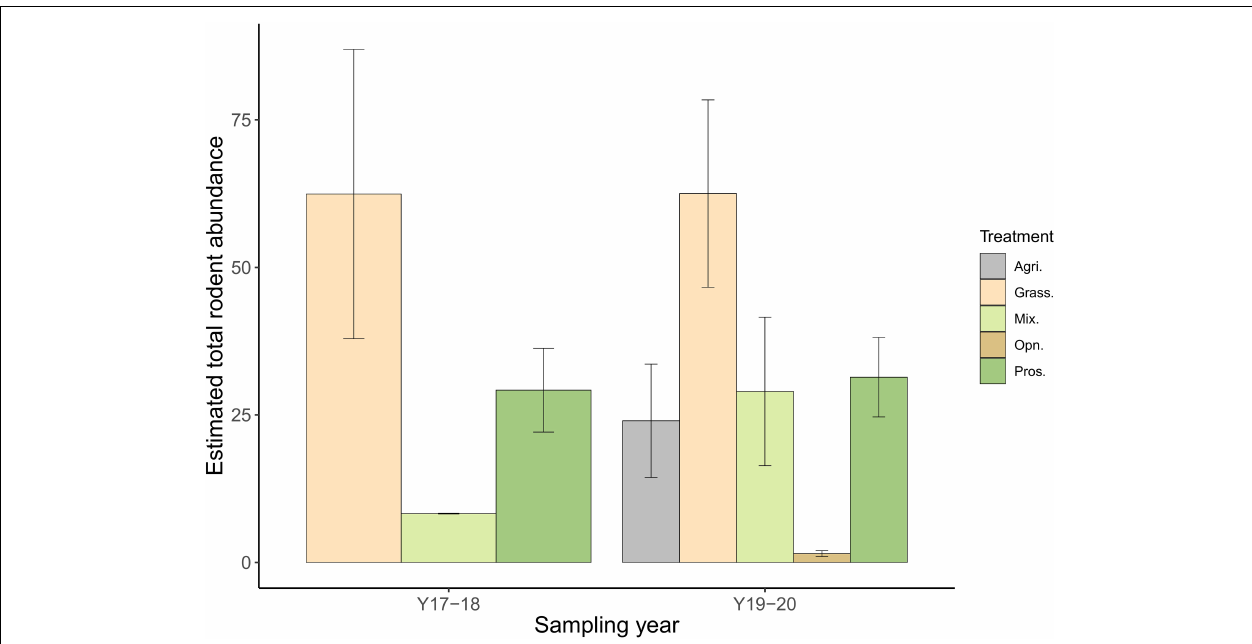
FIGURE 5 | Difference in estimated total rodent abundance between different habitat types and year. There was no significant difference observed ( t = 1.125, p = 0.298) in estimated total rodent abundance between sampling years in grassland ( N 2017 − 2018 = 3, N 2018 − 2019 = 8) ( t = 0.002, p = 0.998), Prosopis dominated habitat ( N 2017 − 2018 = 3, N 2018 − 2019 = 7) ( t = 0.191, p = 0.852), and sparse Prosopis habitat ( N 2017 − 2018 = 3, N 2018 − 2019 = 6).